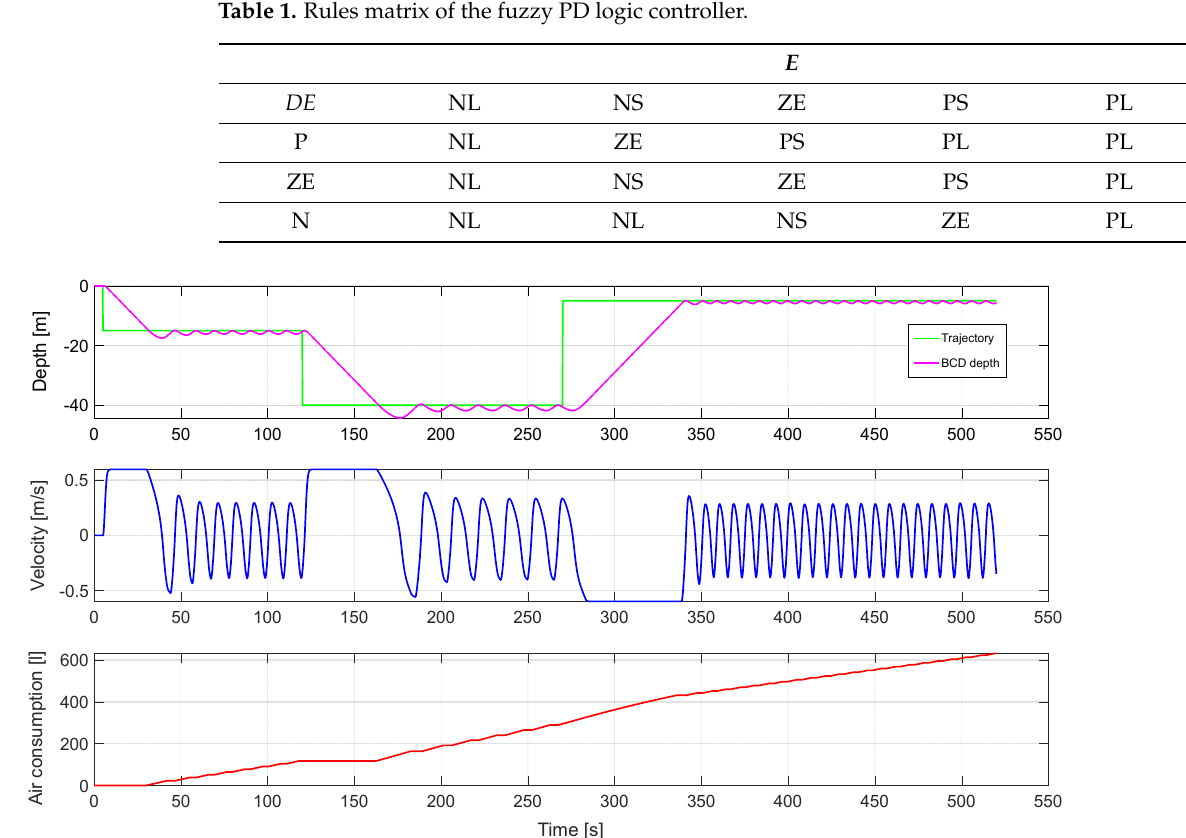
Figure 5. Control results obtained before optimization process.